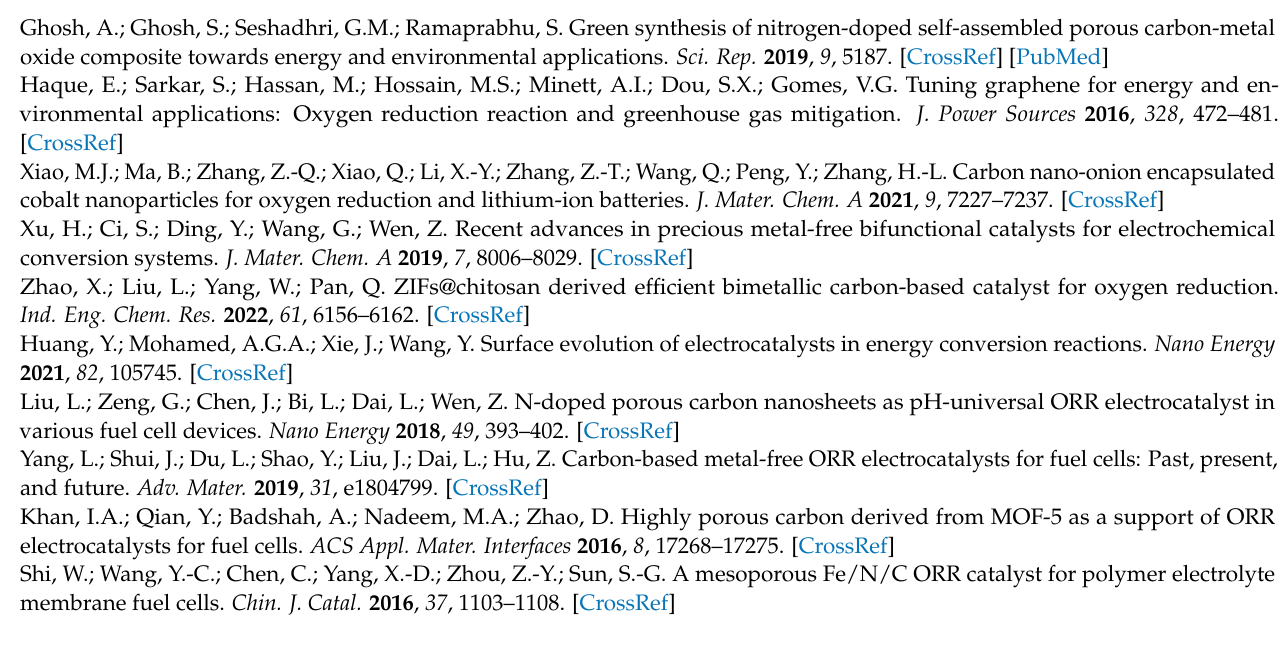
based electrocatalysts in alkaline electrolyte.; Table S2: Calculation of average crystallite size from XRD results using Scherrer formula.; Table S3: BET surface area, pore volume and pore size of CN-800.; Table S5: Deconvolution results of N 1s XPS spectra of CeO 2 –CN–600, CeO 2